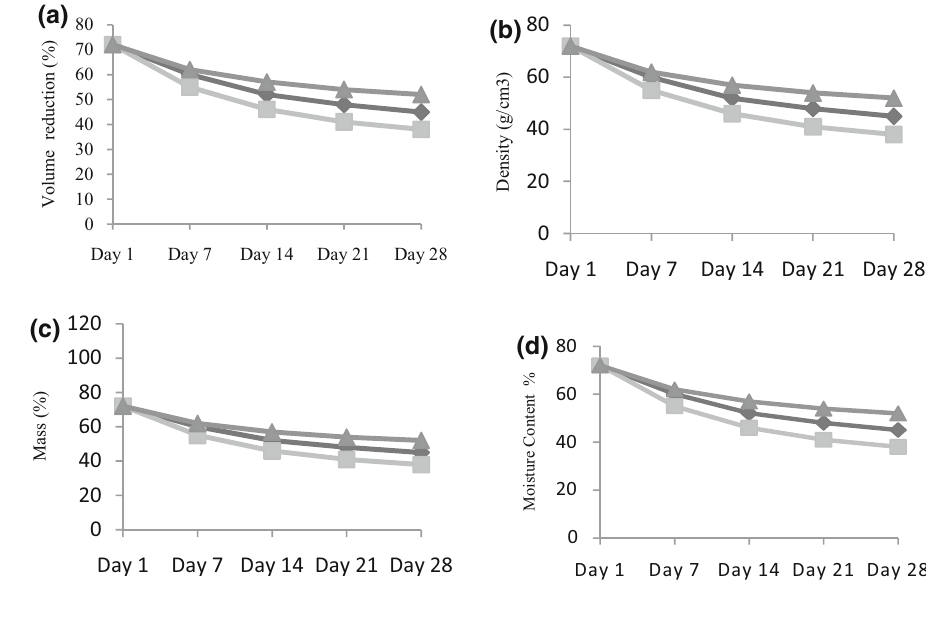
Fig. 3 Determination of